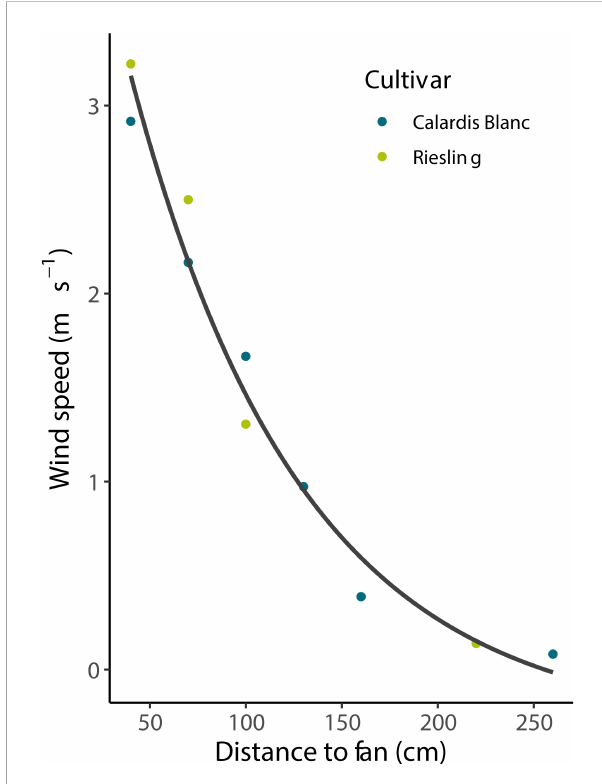
FIGURE 5 Wind speed as affected by the distance from the column fan. Line represents a second order polynomial fi t that was used to predict wind speed at the location of individual clusters by measuring their distance to the column fan.